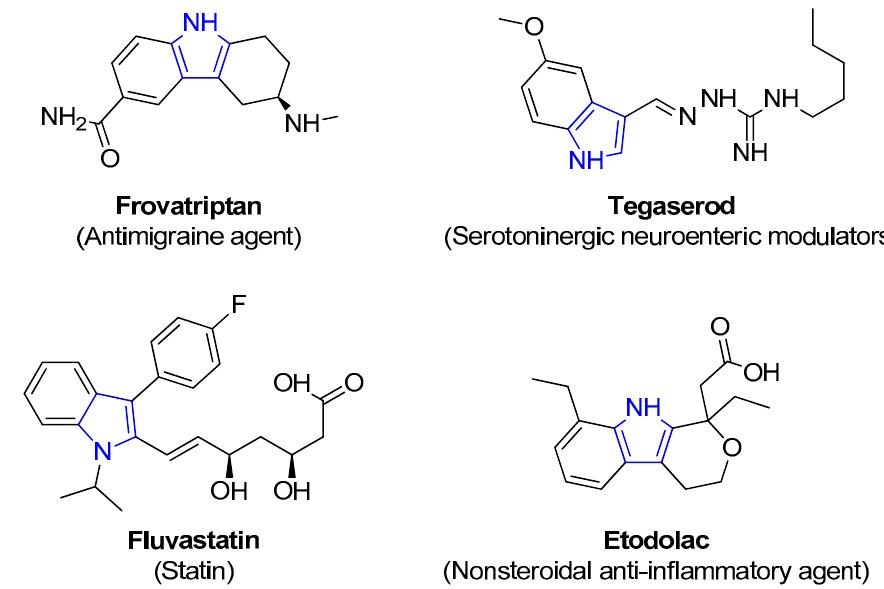
Figure 7. Drugs containing an indole ring.